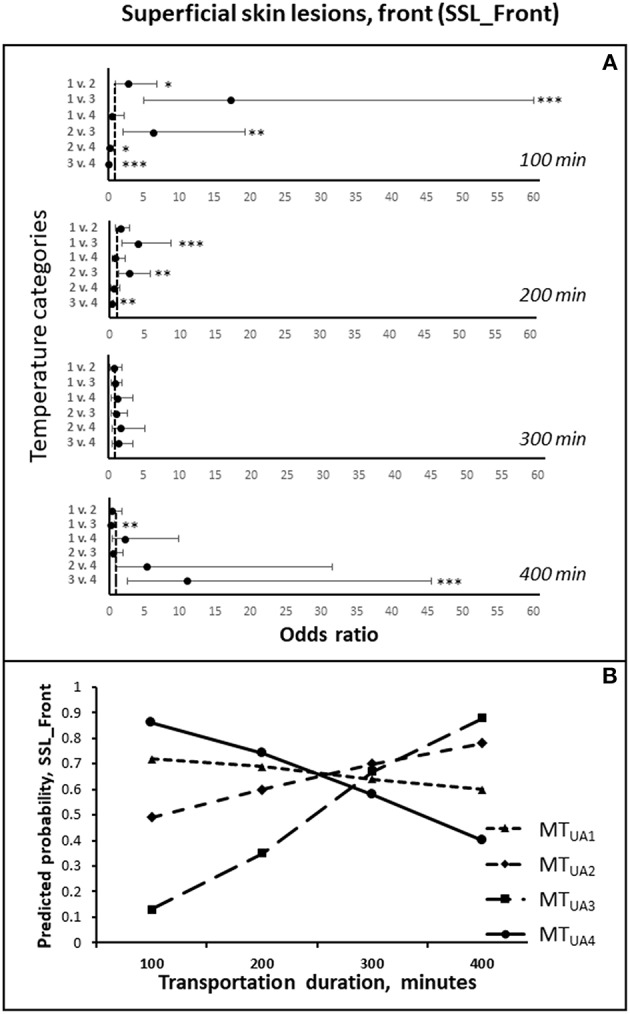
(A) The odds ratios (LSMEANS and 95% confidence intervals) of getting more superficial skin lesion on the front during transportation (SSL_Front), comparing the four temperature intervals, at estimated transportation durations of 100, 200, 300, and 400 min, respectively. The odds ratios are shown on the X-axis, and the numbers 1–4 on Y-axis represent the four temperature intervals: 1 = MTUA1 (0–10°C), 2 = MTUA2 (>10–14°C), 3 = MTUA3 (>14–18.4°C), 4 = MTUA4 (>18.4°C) (Table 5). (B) The predicted probabilities of getting more SSL_Front during transportation for each of the four temperature intervals, estimated for transportation durations of 100, 200, 300, and 400 min, respectively. * P < 0.05; ** P < 0.01, *** P < 0.001.